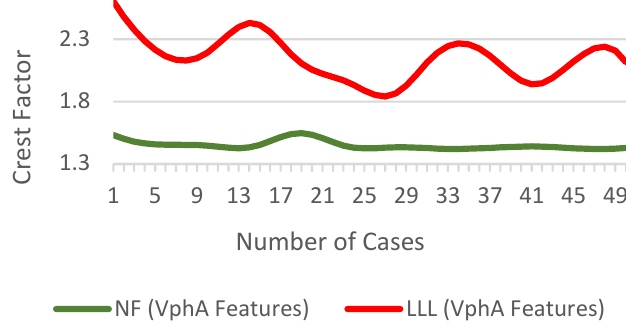
Figure 14. CRES of Iph A for NF and fault conditions.